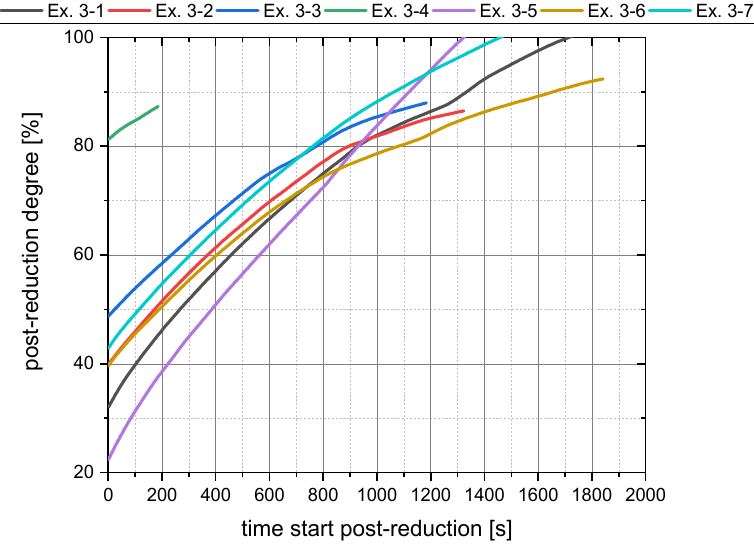
Figure 8. Post ‐ reduction (Phase 5) trend for the main trials. Figure 8. Post-reduction (Phase 5) trend for the main